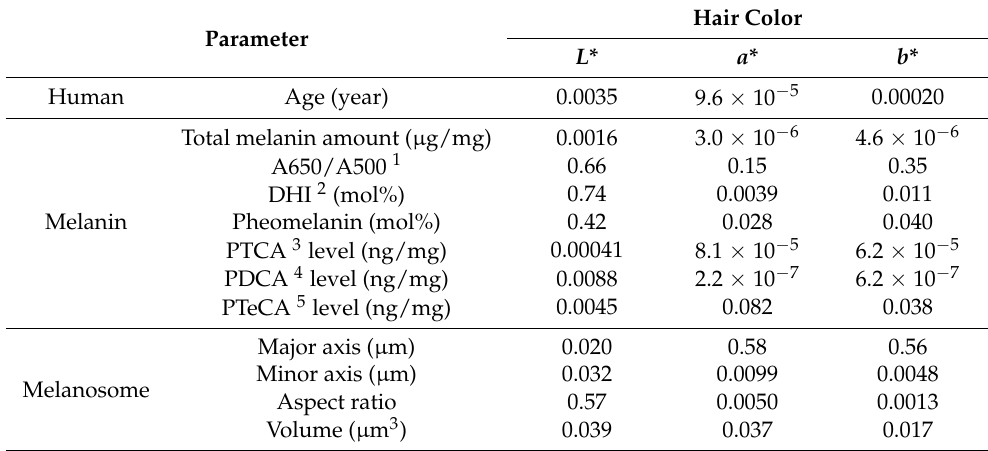
Table 1. p -values from the regression analysis between hair color parameters and various